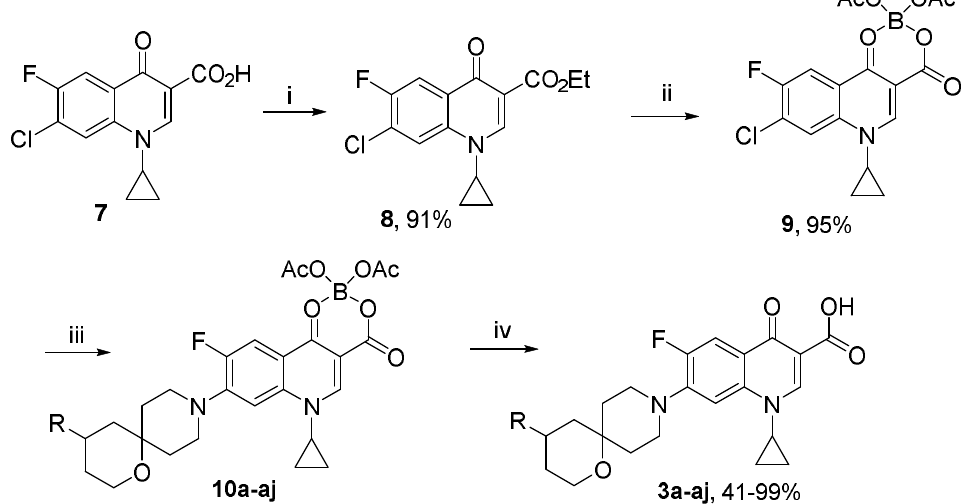
Table 1. Antibacterial activity (MIC, mg/mL) of compounds 3a–aj against five bacterial strains in comparison with ciprofloxacin (-: no activity; +: active but MIC is higher than that of ciprofloxacin; ++: MIC same as that of ciprofloxacin; +++: MIC lower than that of ciprofloxacin; NT: not